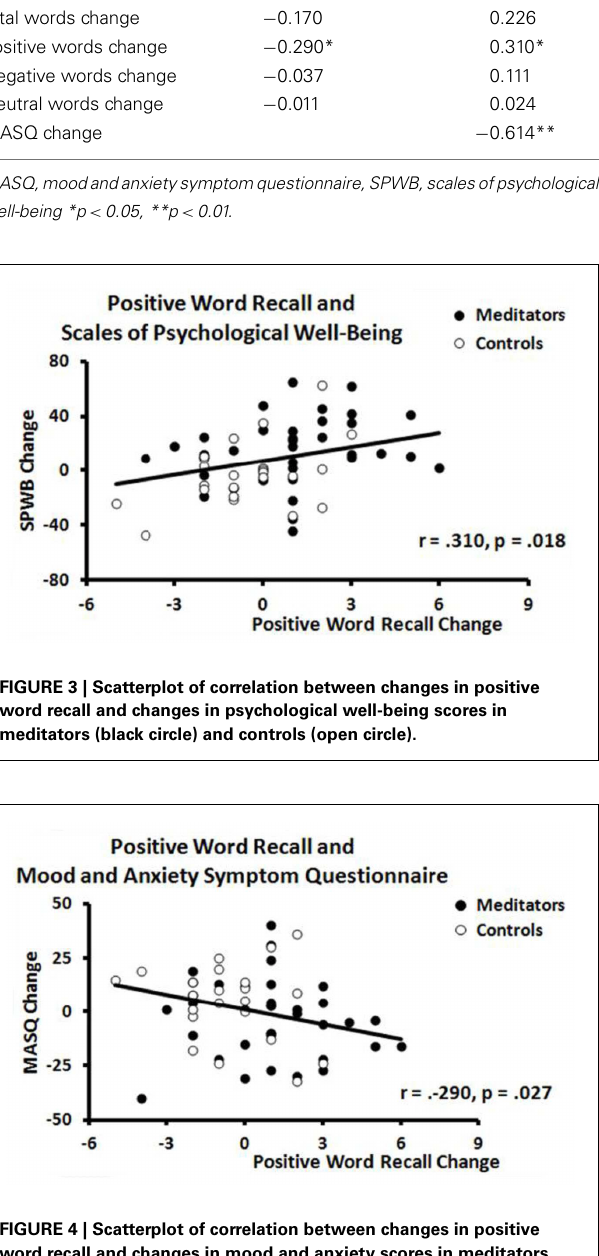
FIGURE 4 | Scatterplot of correlation between changes in positive word recall and changes in mood and anxiety scores in meditators (black circle) and controls (open circle).